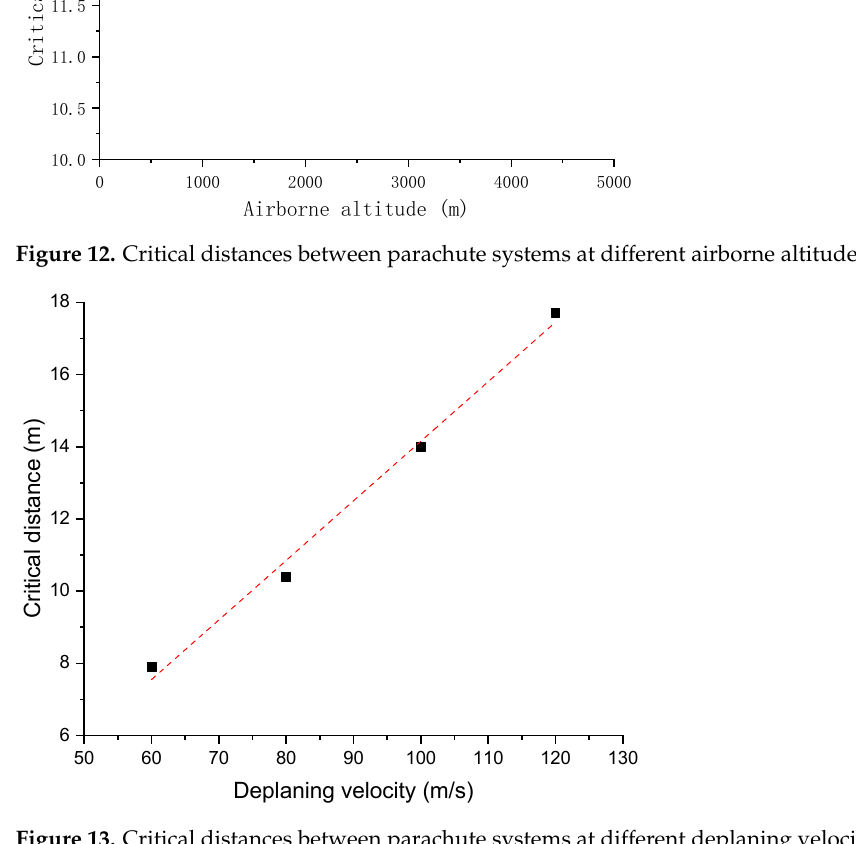
Figure 12. Critical distances between parachute systems at different airborne altitudes.